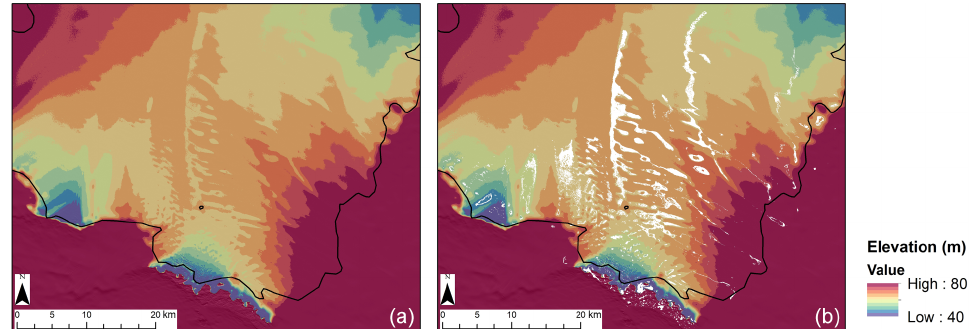
Figure 4. REMA DEM data for the Nivlisen Ice Shelf. (a) The DEM and (b) overlain with the maximum melt extent matrix for the 2016– 2017 melt season in white. DEM data sourced from the REMA dataset (Howat et al.,